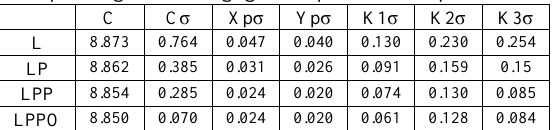
Table 5. Sigma statistics for M1. L – Landscape, P – Portrait -90°, PP - Portrait ±90°, O – Oblique M2 and M3 consisted of images taken at three altitudes, with rotations with respect to the direction of travel along with four